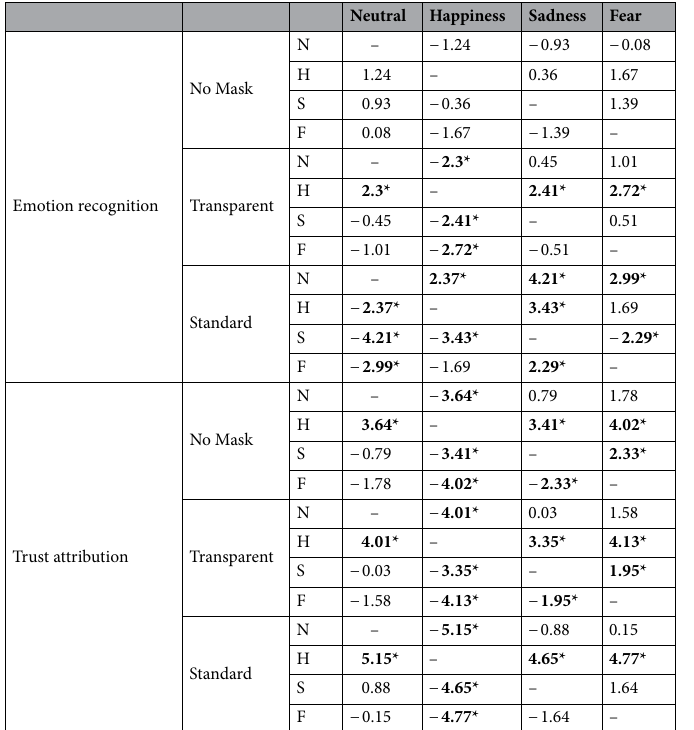
– Table 1. The table illustrates, for each condition, the results of the post-hoc analyses (Friedman test) comparing couples of posed expressions in both the “Emotion recognition task” (upper panel) and the “Trust attribution task” (lower panel). Reported values indicate the Z statistic of the Wilcoxon signed-rank test post hoc comparisons (Bonferroni corrected). Asterisks signal significant results.